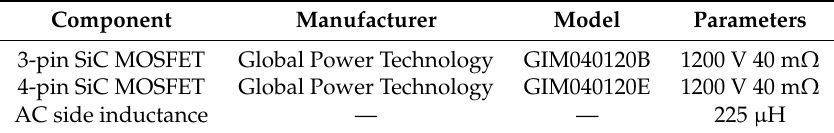
Table 2. Pulse Width Modulation (PWM) rectifier components.